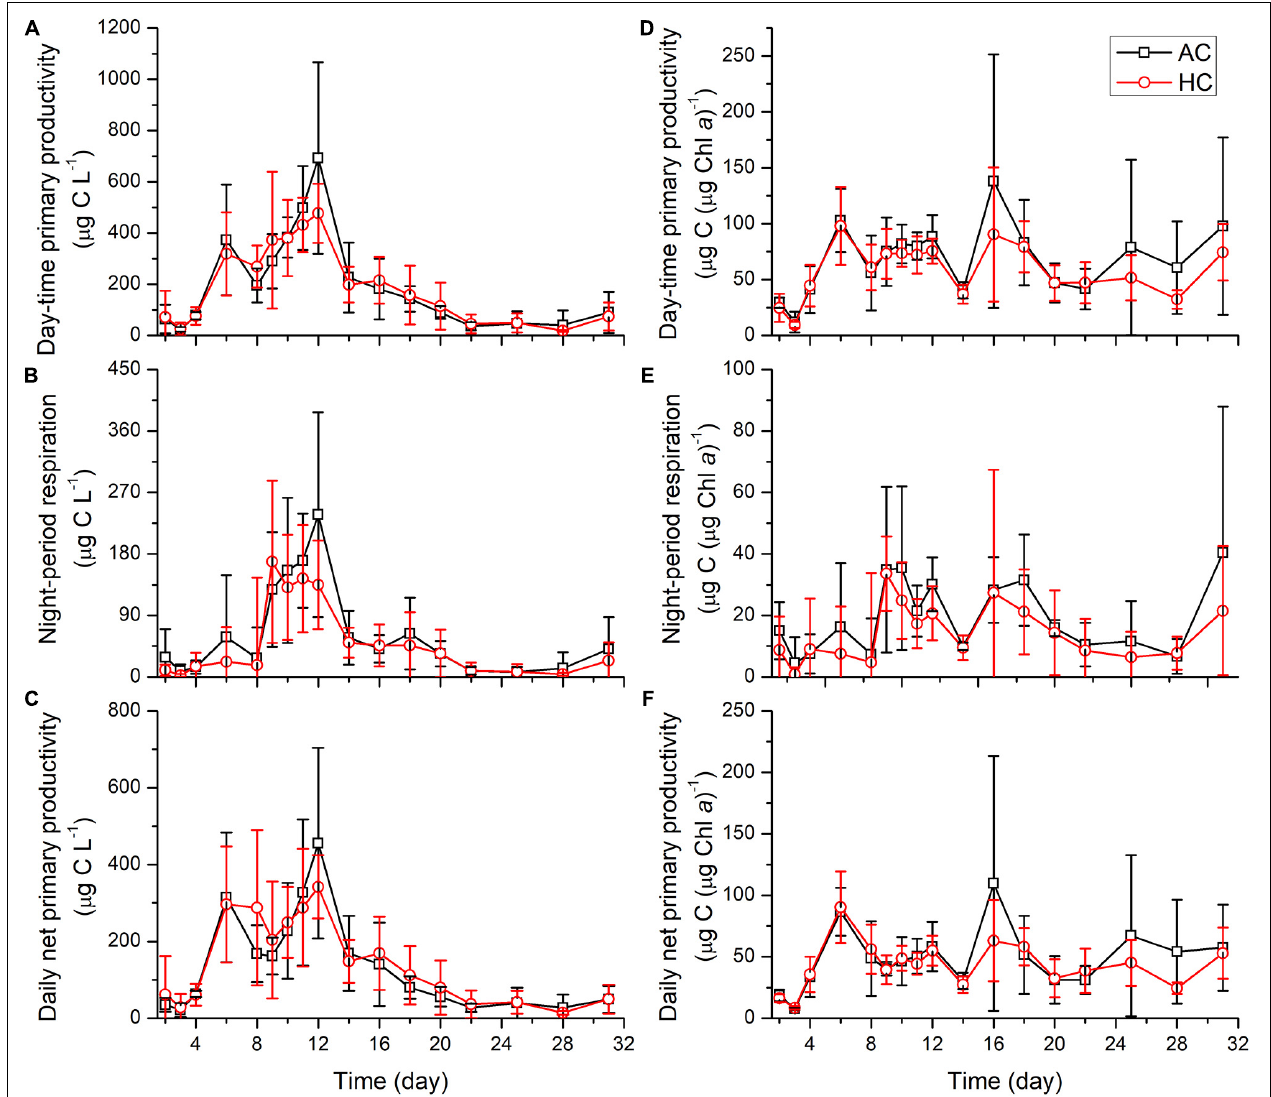
FIGURE 7 | The changes of day-time primary productivity (A,D) , night period respiration (B,E) , and daily net primary productivity (C,F) normalized to water volume (left panels) and to Chl a (right panels) levels, in HC (1000 ppmv) and AC ( ∼ 410 ppmv) treatments. Data are means ± SD of replicates for HC treatments and for AC